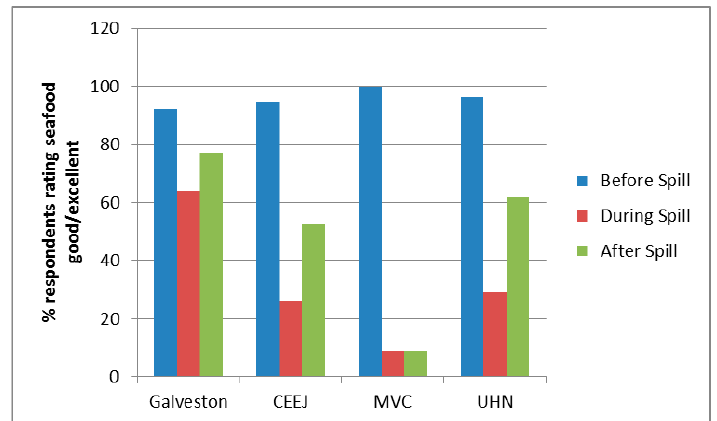
Figure 3. Seafood consumption and perceived quality of Gulf seafood before, during, and following spill. The percentage of respondents from each community that self-reported eating any type of seafood before (blue bars), during (red bars), and after (green bars) the oil spill (upper panel), and perceived quality of seafood before, during, and after the spill (lower panel).